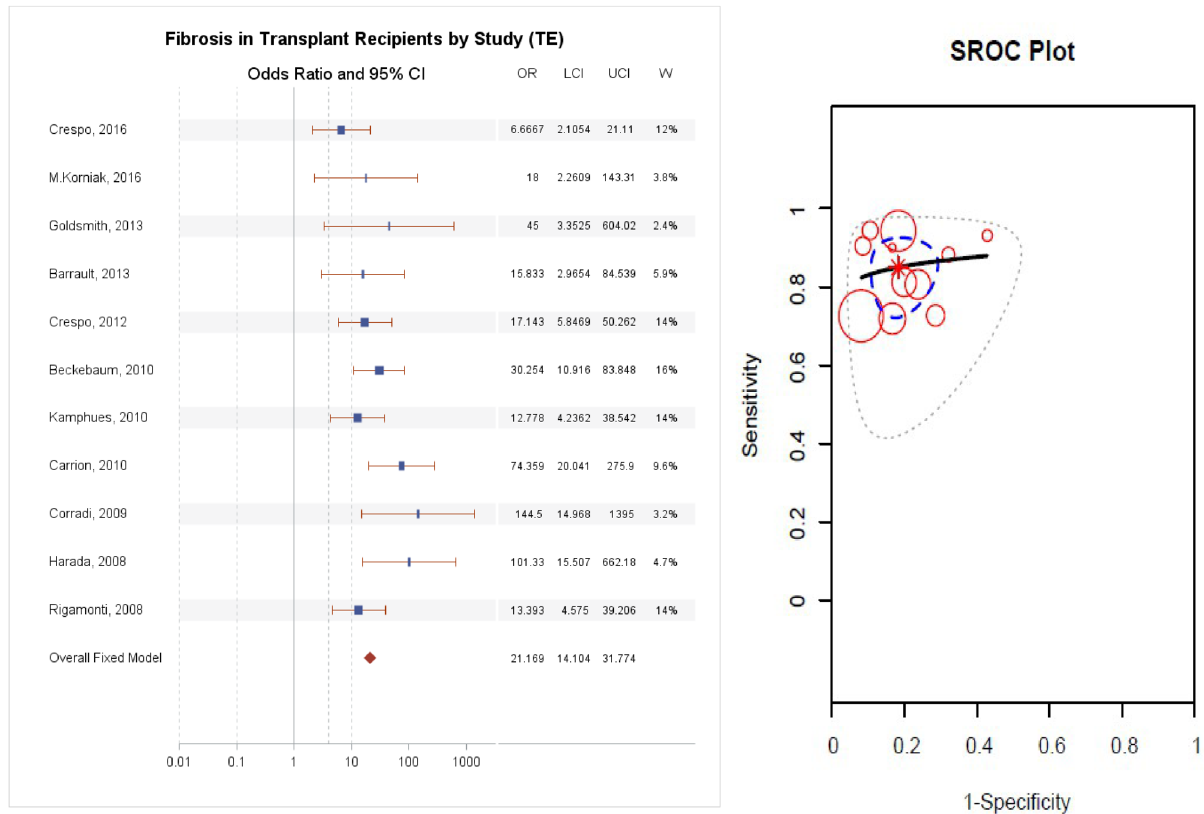
Fig 4. (A) Diagnosticaccuracy of Fibroscanfor the predictionof F2-4 fibrosis, (B) Summary